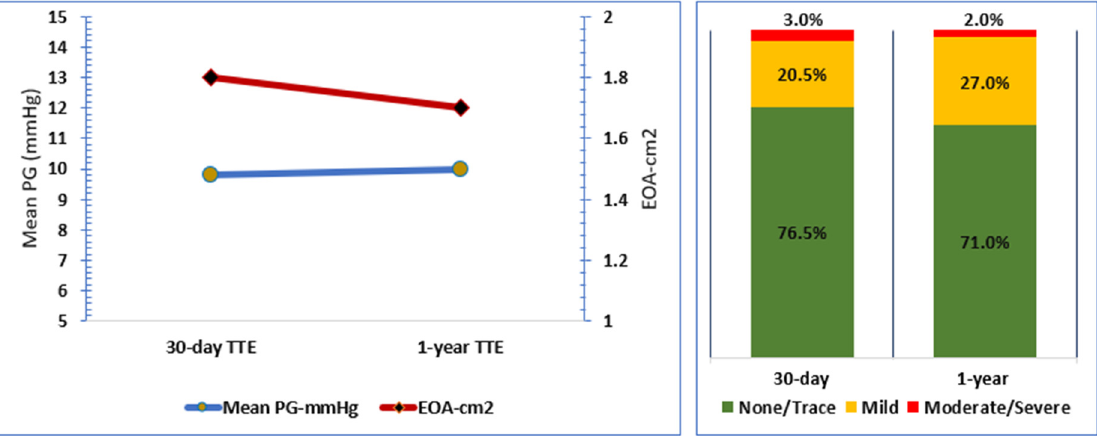
Figure 1. Haemodynamic performance at 30-day and 1-year